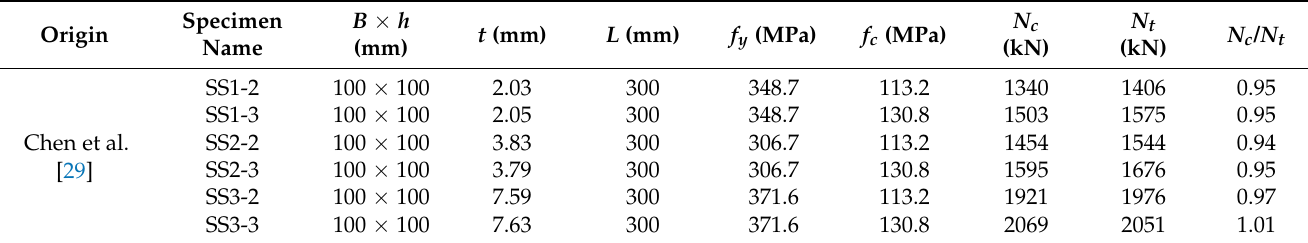
Table 1. Details of stub rectangular UHPCFST specimens under axial compressive load.